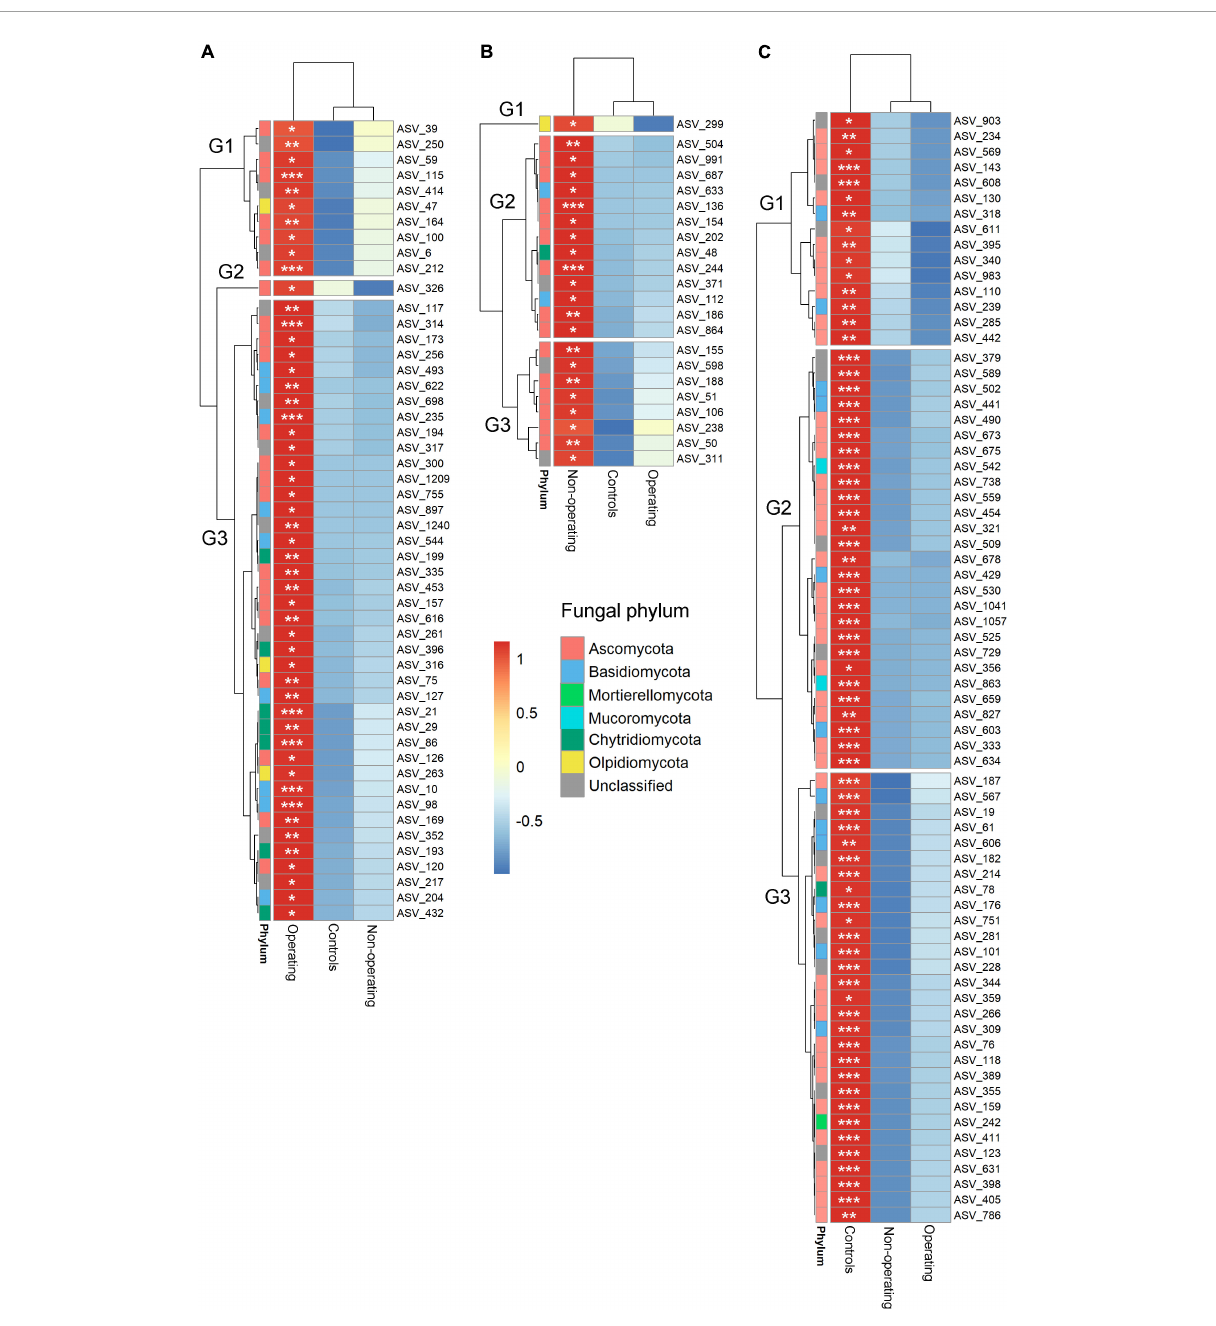
( Figure 6C and Supplementary Tables 10-12 ). Relative